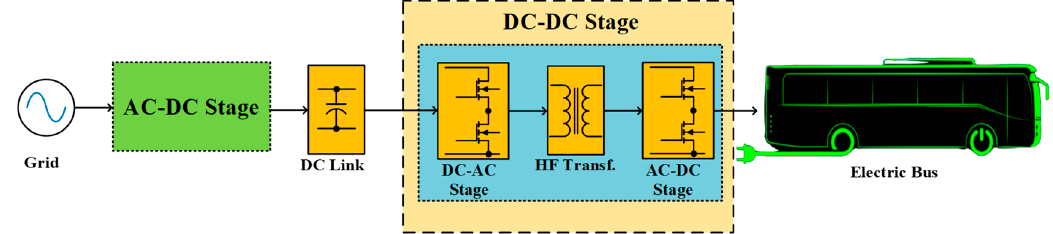
Figure 3. Block diagram for a typical charger.